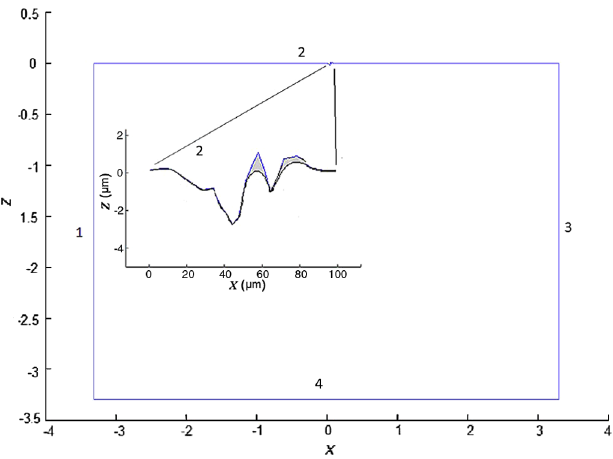
FIG. 8. Typical temperature simulation area in 2D dimension: Borders are labeled in numbers. Borders 2 and 4 are rf surface and helium interfaces respectively, and borders 1 and 3 have thermal isolation boundary conditions. Inset: The surface roughness feature is highlighted. The grey area represents the internal heat source location. Unit: μ